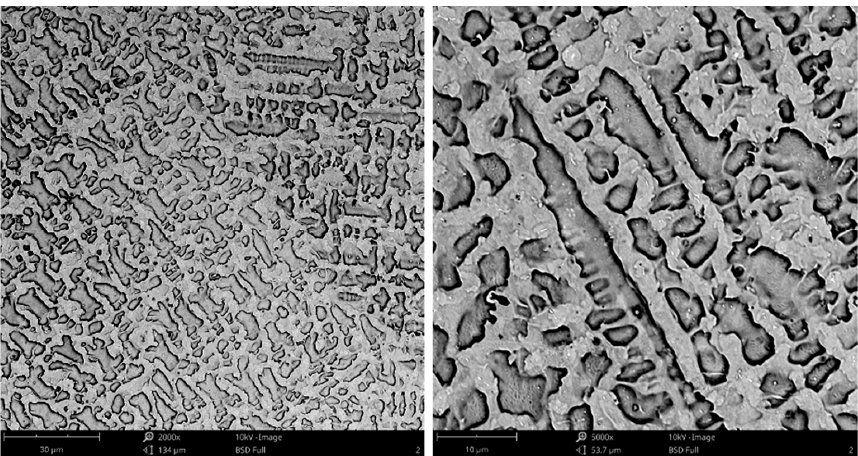
Figure 5. Microstructure of the representative metallic Inconel 625 coating.